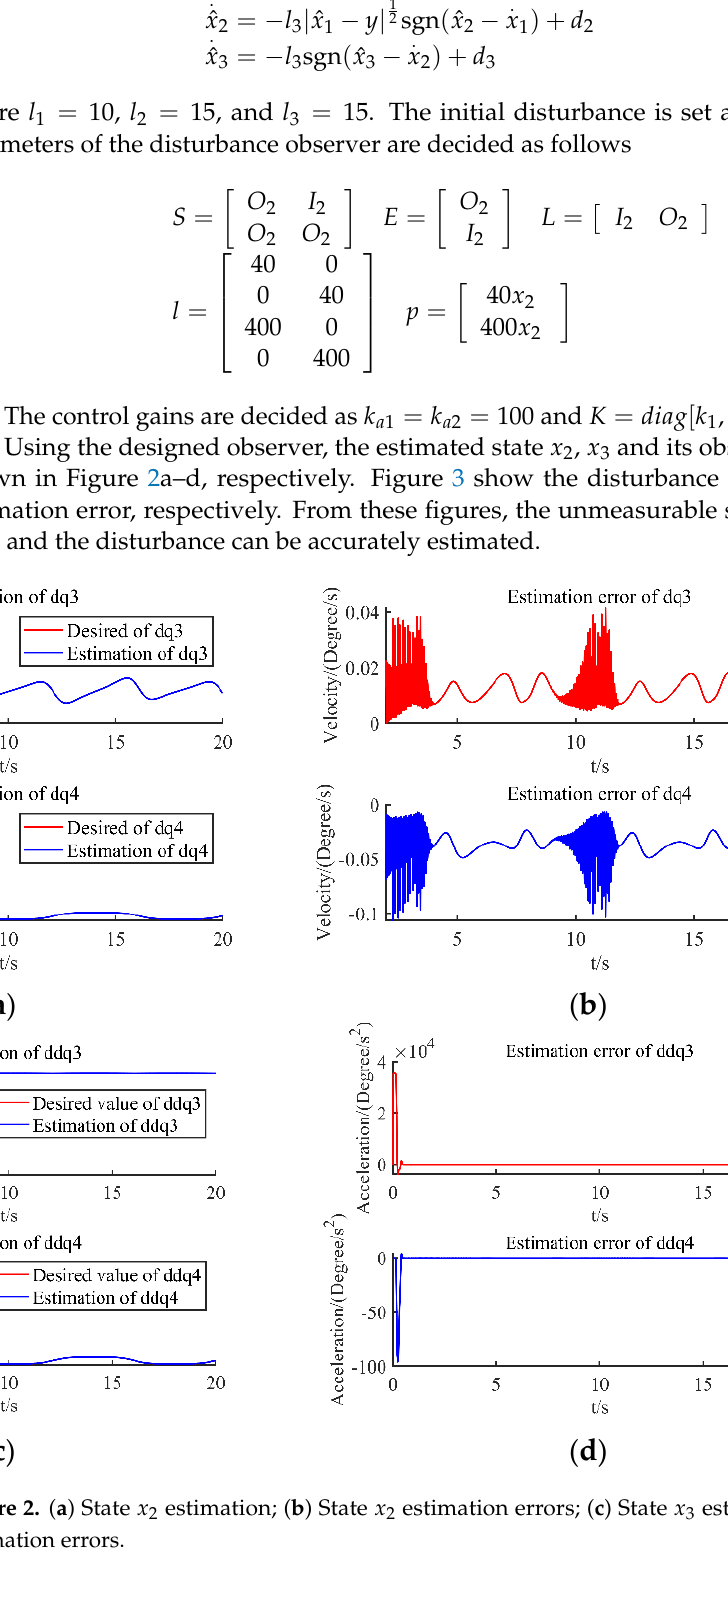
Figure 3. Disturbance observation.